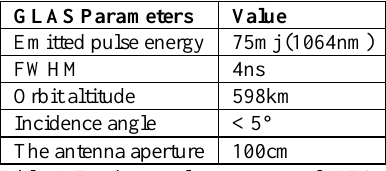
Table 1. Fundamental parameters of